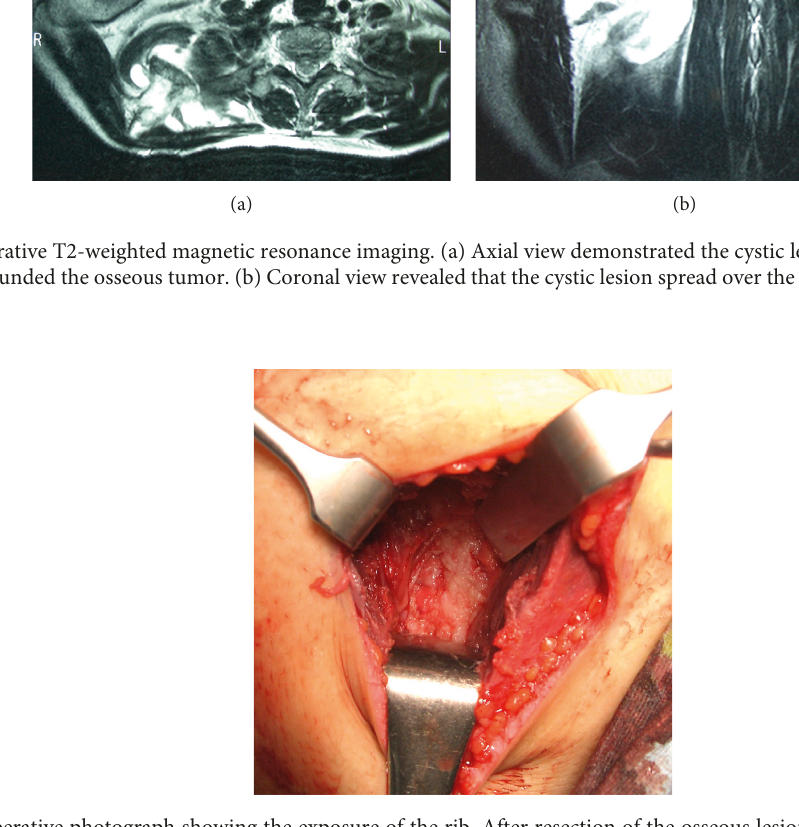
Figure 4: Intraoperative photograph showing the exposure of the rib. After resection of the osseous lesion, a large cystic space appeared, covered by a white thick membrane; at the bottom of this space, a 1 × 3cm section of rib surface covered by edematous synovium was exposed in a defect of the thick